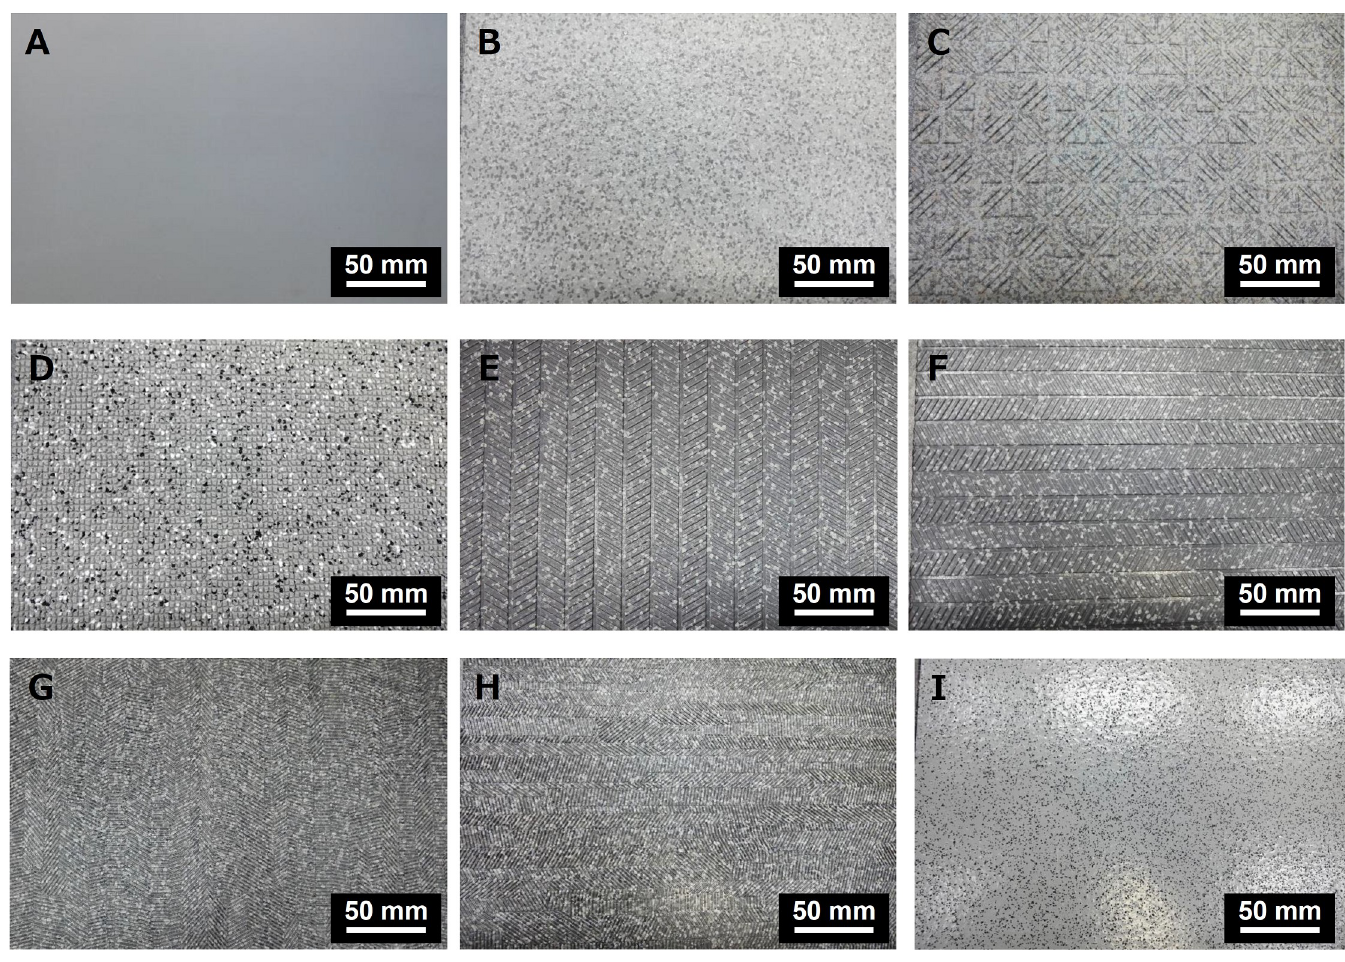
Fig 1. Photos of test sheet